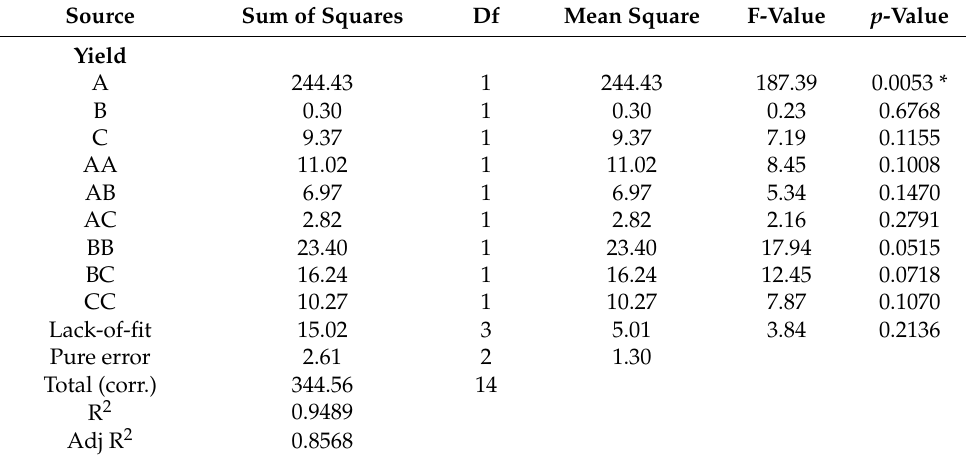
Table 5. ANOVA results for response surface quadratic models of TS extraction by SFE-CO 2 .